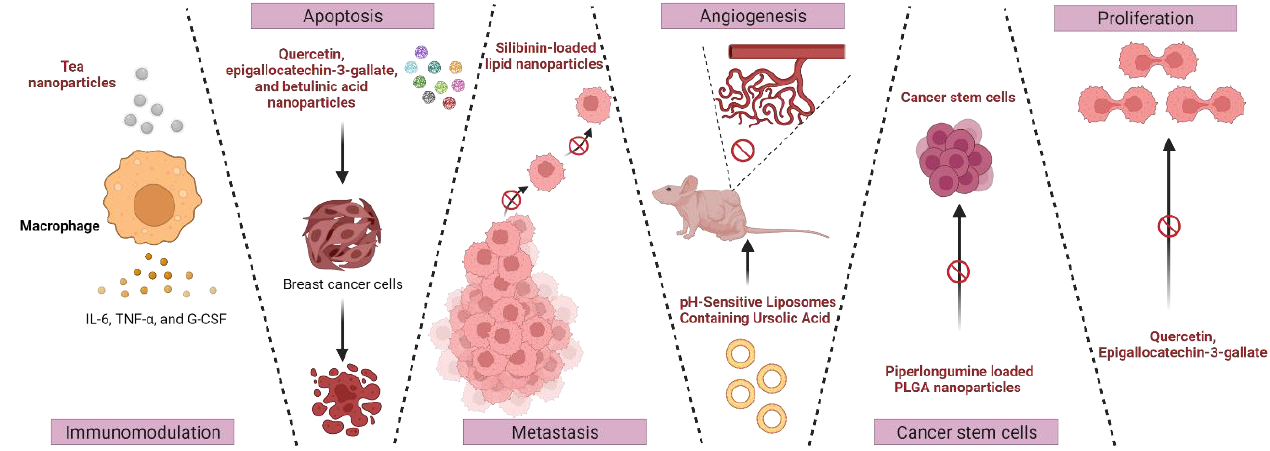
Figure 6. Illustration of the effect of phytofabricated nanocarriers on various mechanisms involved in the progression of cancer. Created with BioRender.com accessed on 21 December 2022.